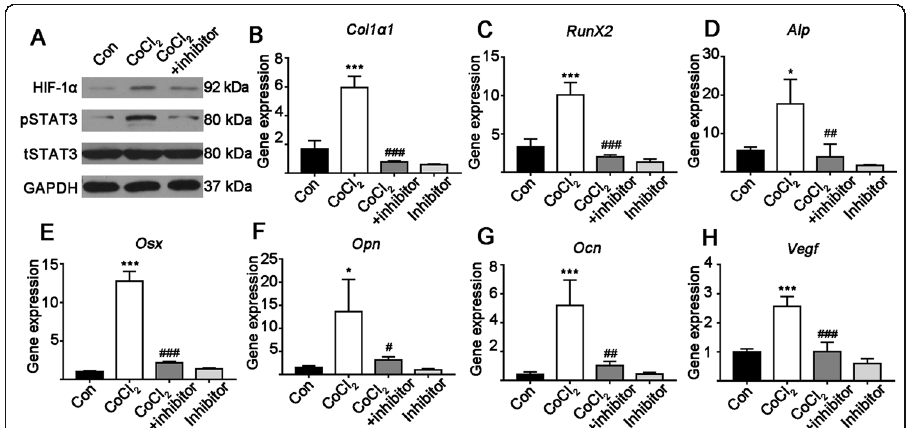
Fig. 3 The effect of continuous hypoxia for 3 days with or without a STAT3 inhibitor. a Representative western blot images. b - h The effect of 3 days of hypoxia with or without a STAT3 inhibitor on osteogenic marker and Vegf gene expression in MSCs. Data of quantitative analysis are the means ± SD from 5 independent experiments, n = 5. Significant effect of the treatment compared to the control group: * p < 0.05 and *** p < 0.001; and the CoCl 2 group: # p < 0.05, ## p < 0.01 and ### p < 0.001